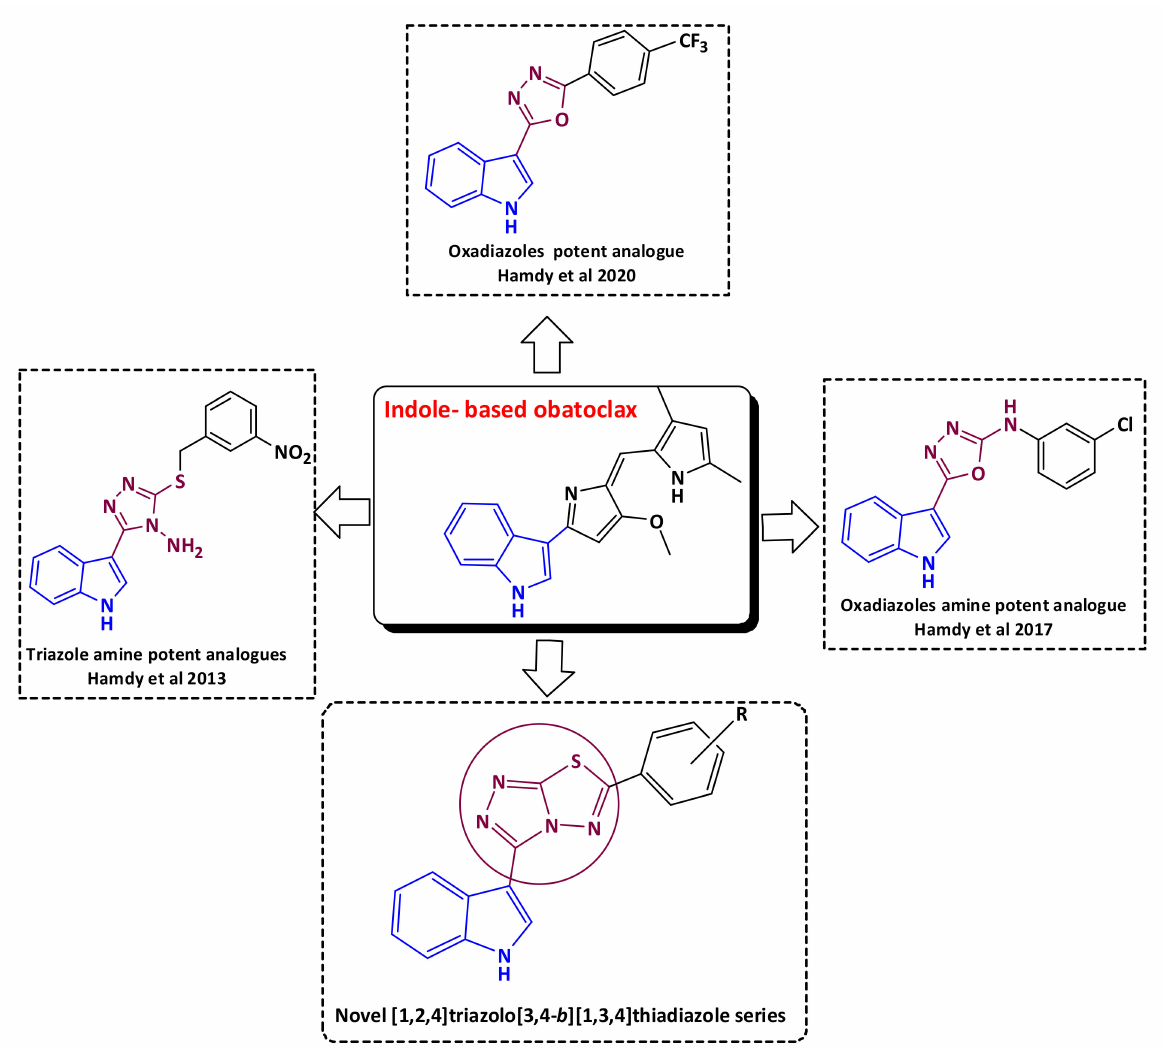
Figure 1. Rational design of the novel fused triazole-thiadiazole